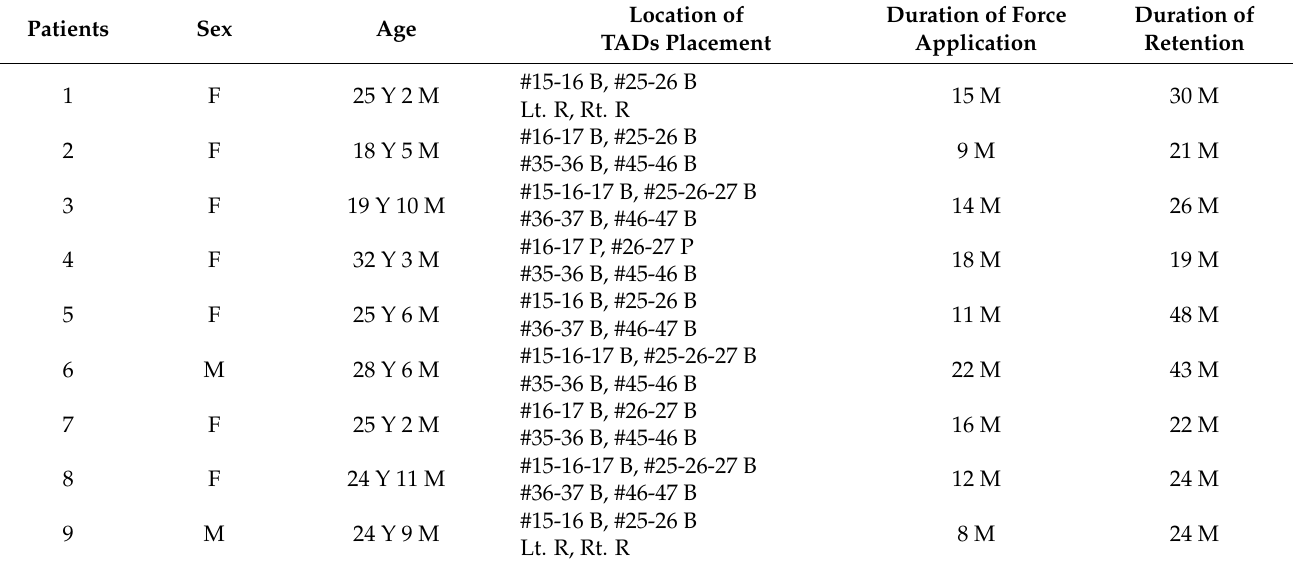
Table 1. Descriptive distribution of the